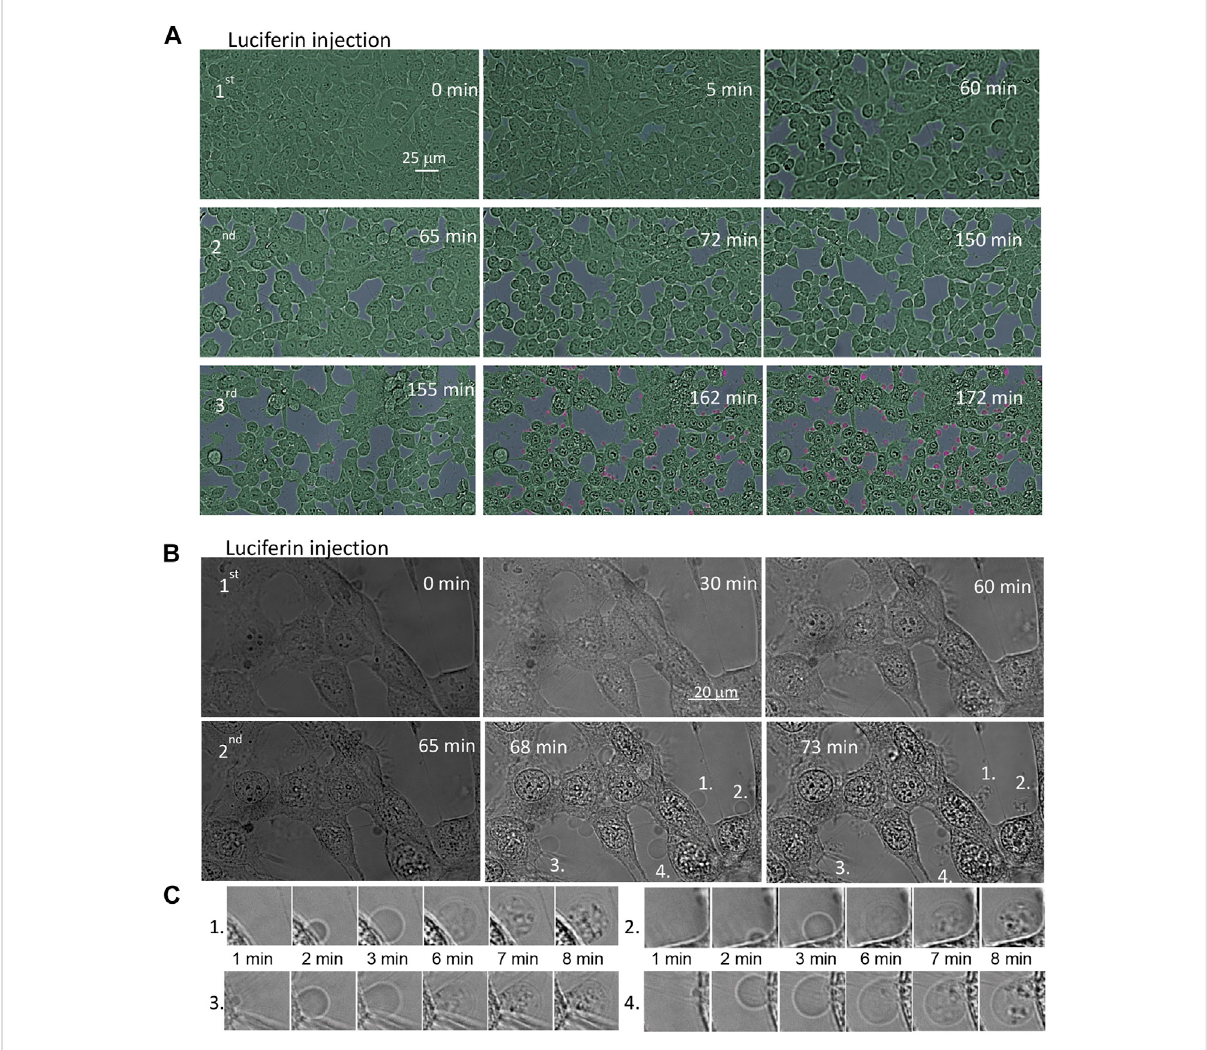
Time course of the morphological changes of the HCT116 colon cancer cell line treated with 150 nM TiDoL in the presence of ATP (20 μ M). After 20 min of incubation, an aliquot of luciferin (15 μ M fi nal concentration) was injected to the well and the response of the cells was monitored using the transmission mode of a confocal microscope. Cells incubated (A) in the McCoy culture media (absorption ≤ 600 nm); three aliquots of luciferinwereadded(45 μ M fi nalconcentration)at60 minintervalstoinducecellshrinking(cellinterspaceshadedingray)andbudding(shaded inpink).Magni fi cation×40.Forclarity,cellswereshadedingreen andextracellularspaceingray. Cellsincubated (B) inHanks ’ BalancedSalt Solution (absorption ≤ 300 nm); two aliquots of luciferin were suf fi cient to cause cell budding. Magni fi cation ×126. (C) Time course of formation, growth, and transfer of cell material to the apoptotic bodies after the second luciferin